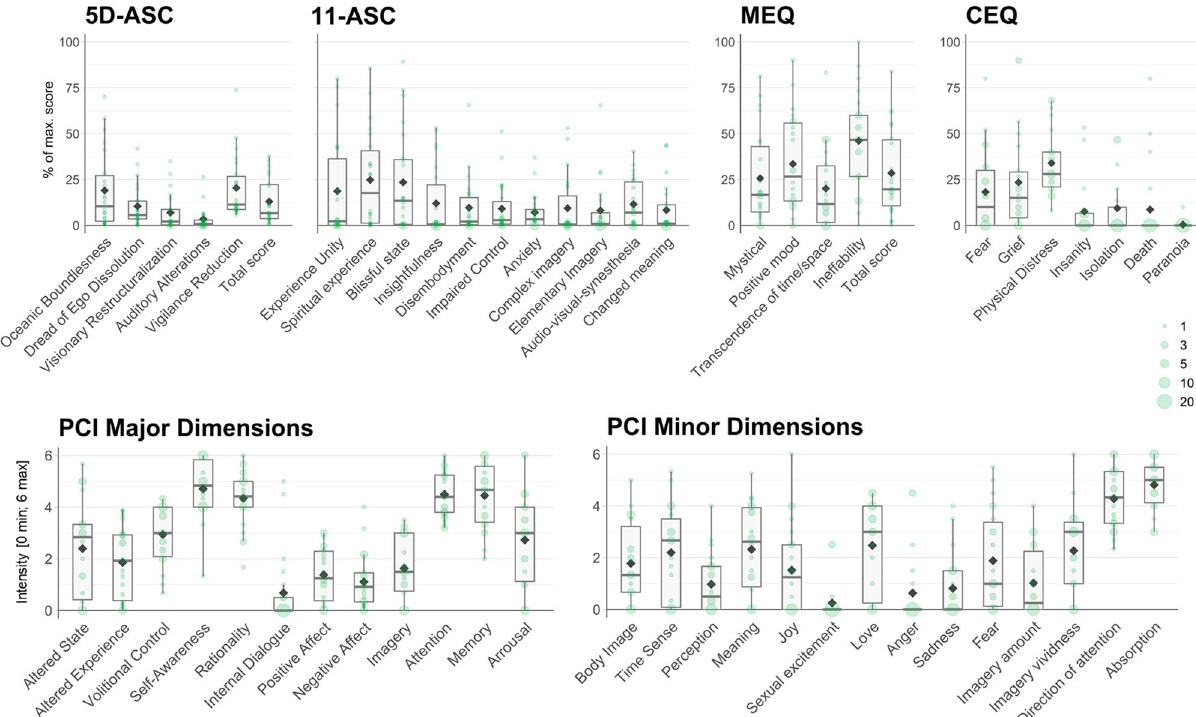
Figure 1. Retrospectively reported acute subjective effects of Kambô. Acute effects (n = 22) were assessed with standardized psychometric tools that allow comparisons to consciousness alterations induced by different methods as e.g. found on the Altered States Database 17 . The scores of the ASC, MEQ and CEQ are designed to assess differences from zero, while the PCI items are anchored with two opposing statements (See “Methods”) to the end of the scale [0: minimum; 6: maximum], thereby not assessing differences from zero but characterizing the overall pattern of experience. In comparison to Table 2, the box plots provided here show the data